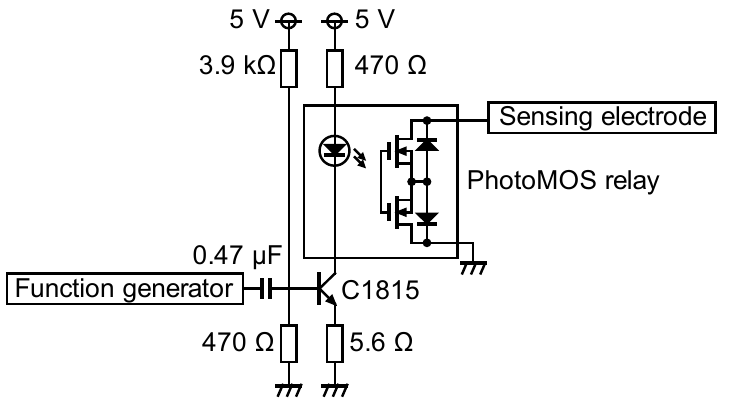
Figure 16. Circuit for switching the resistance of the sensing circuit. Panasonic AQV258 was used as the PhotoMOS relay, which has the rated peak current of 0.06 A. The maximum current from the sensing electrode may have exceeded this value in the experiment, although no operation problem was observed. Additional resistance may be added in series for reducing the